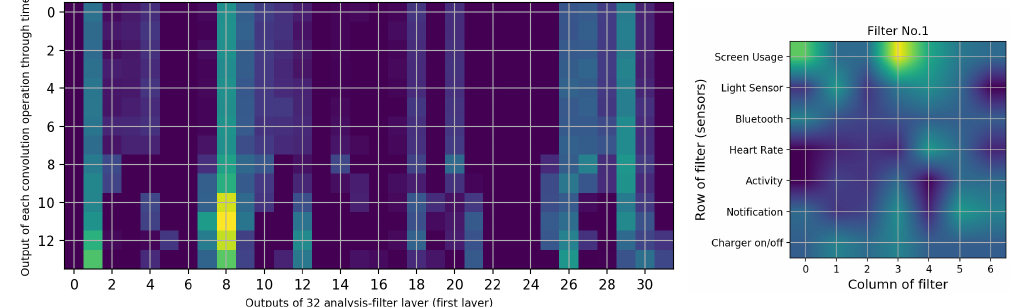
Figure 9. Outputs of analysis-filters for input number 281 ( left ) and heat map of filter number 1 ( right ). The main role of filter 8 is highlighted in Figure 9 (left) with a lighter color (yellow). Changes in the brightness of columns 8 and 1 can be mapped to the result of the filters. Figure 9 (right) shows filter number 1. For the sake of brevity, the sensors’ time-series for input 281 in Table 9 are shown in Figure A1 in the Appendix